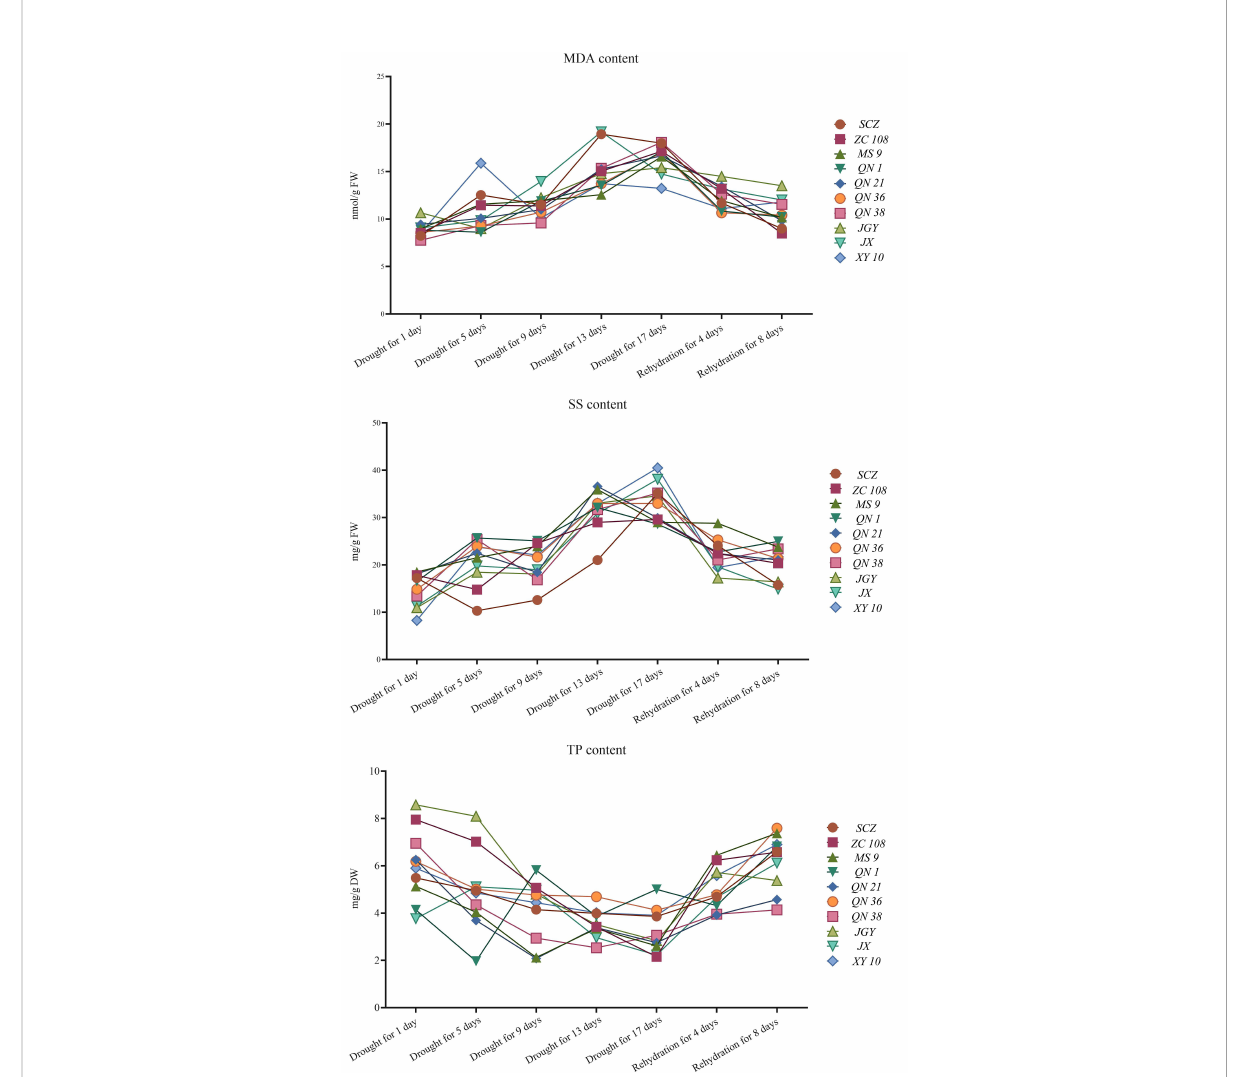
FIGURE 4 Change trend of physiological indexes (malondialdehyde, soluble sugar and tea polyphenol content) of tea germplasm